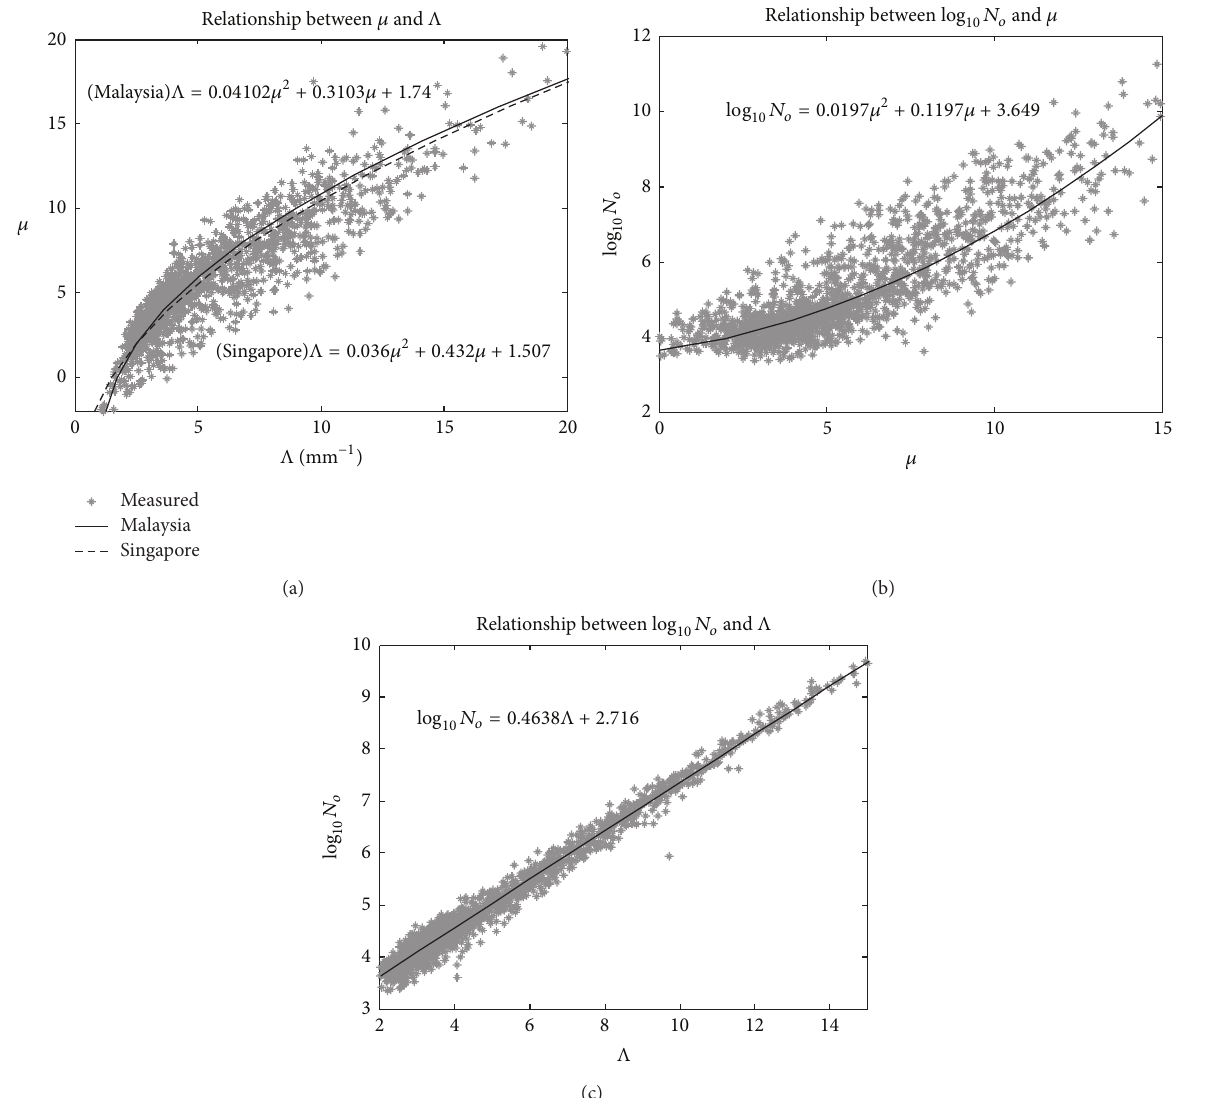
Figure9:(a)Relationsbetween 𝜇 - Λ valuesobtainedfromdisdrometerdataandtheircorrespondingfit.Thecurveobtainedthroughempirical relationship from Singapore is also included for comparison. (b) Relation between log 10 𝑁 𝑜 - 𝜇 values obtained from disdrometer data and their corresponding fit. (c) Linear Relation between log 10 𝑁 𝑜 - Λ values obtained from disdrometer data and their corresponding